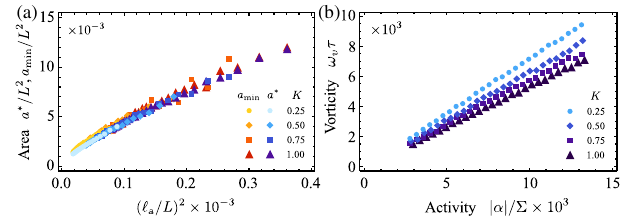
FIG. 4. Probability distribution function of the velocity com- ponents (a) and vorticity (b). All of the data are normalized FIG. 3. (a) The areas a (red tones) and a (cid:4) (blue tones) min by their corresponding standard deviation. The black solid appearing in the vortex probability distribution Eq. (3) for various line represents a unit-variance Gaussian function: f ð x Þ ¼ ffiffiffiffiffi p 1 = 2 π ≈ a (cid:4) ∼ l 2 ’ mean vorticity ω exp ð − x 2 = 2 Þ . Velocity (c) and vorticity (d) correlation demonstrates that a v a . (b) Vortices min functions (CF) for various activity values. The distance is ffiffiffi p 2 = 2 L , corresponding to the maximal normalized by r max ¼ distance between two points on a periodic square of size L Frank constant.